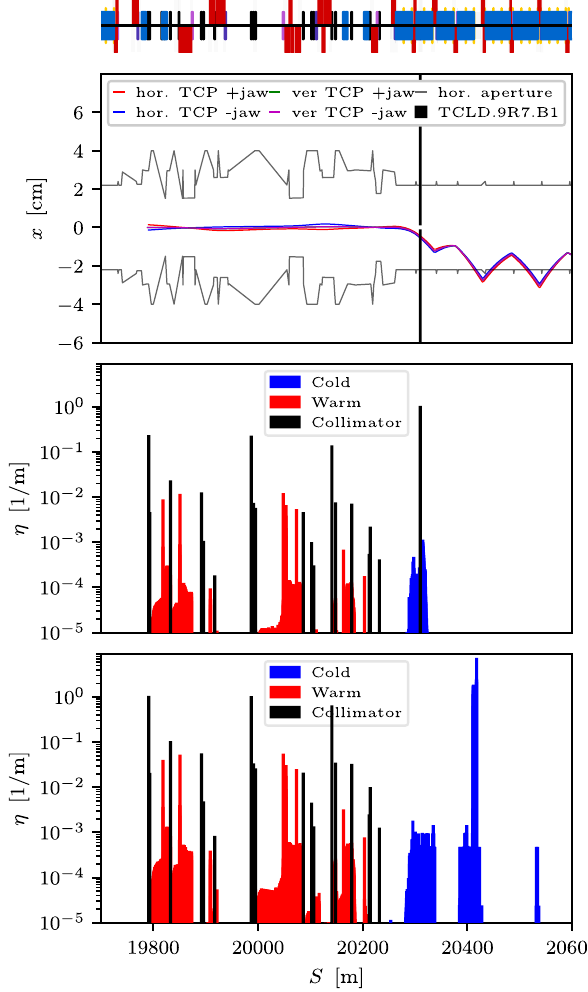
FIG. 6. The top figure shows trajectories calculated with MAD- X of fully stripped off-rigidity 208 Pb 82 þ ions escaping the TCPs together with the aperture model and the TCLD with of 14 σ opening. The middle plot shows the S ix T rack- FLUKA coupling simulation of the loss map for HL – LHC version 1.2, including the TCLD at 14 σ in cell 9. The bottom plot shows the simulated loss map for the same optics but without the TCLD, resulting in the similar loss pattern as observed in the